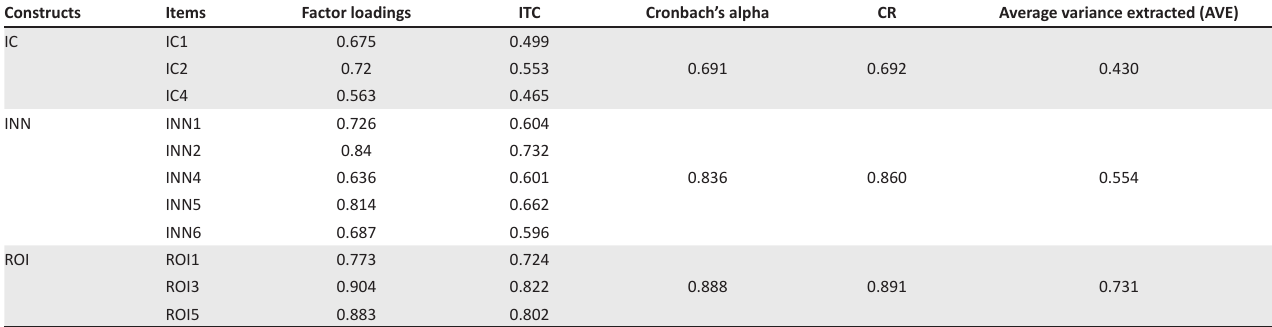
FIG URE 1: Final measurement TABLE 3: Reliability and convergent validity of the scales. Constructs